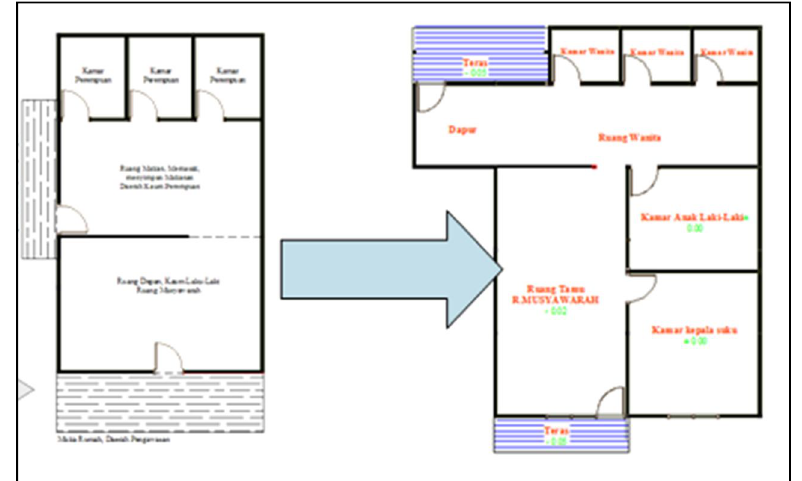
Figure 2. Changes in house layout in “ Imaekholu ” Source: Widyastomo et al,